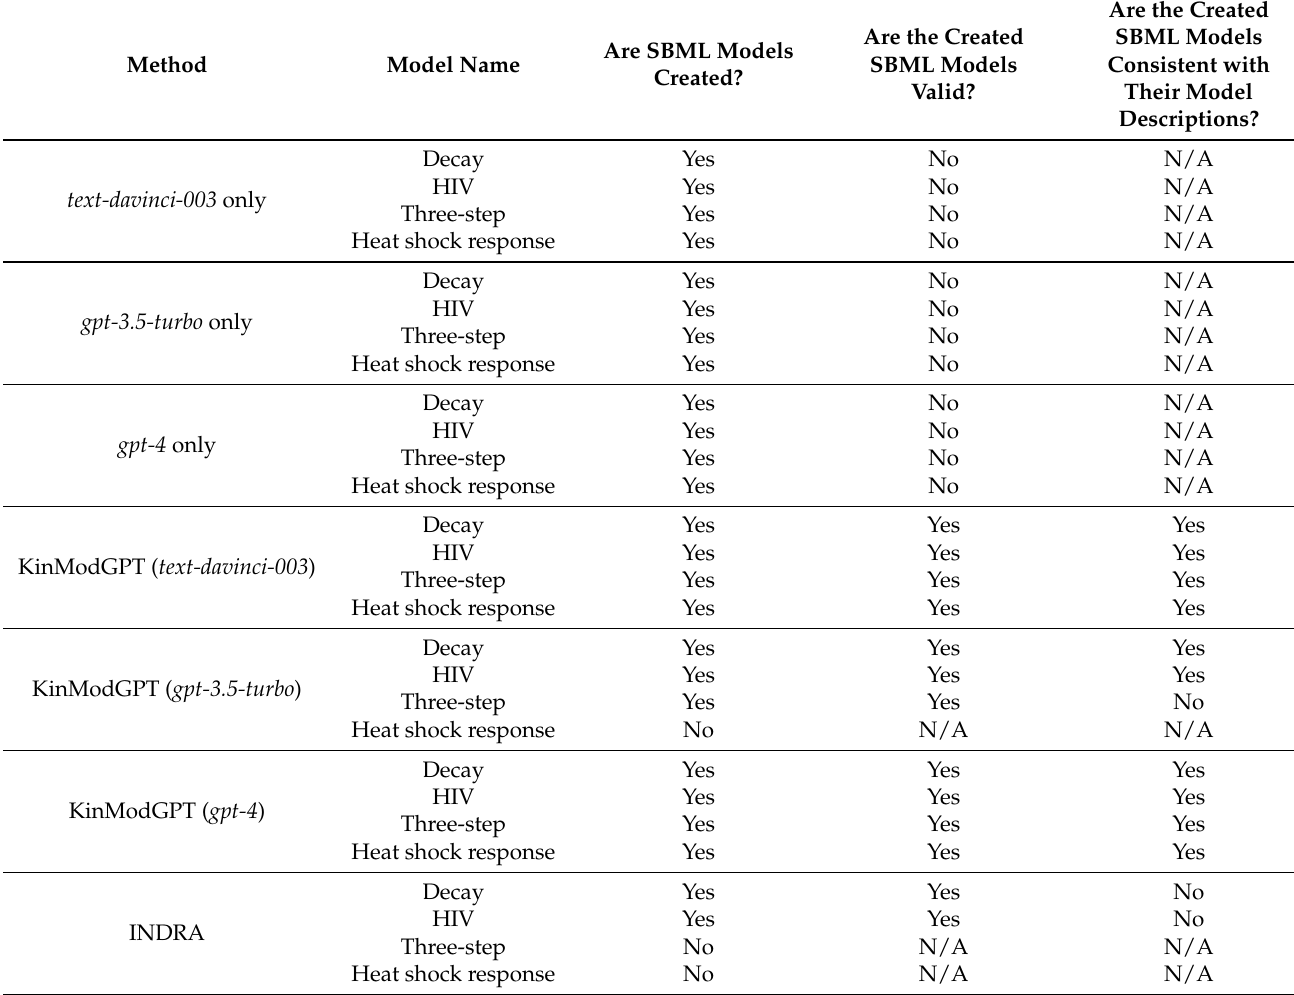
Table 1. Summary of the computational experiments. We converted four natural language model descriptions into SBML, using either of the GPT-only approaches, KinModGPT approaches, or INDRA (a competitor tool). In the KinModGPT approaches, either of the three GPT models ( text-davinci-003 , gpt-3.5-turbo , or gpt-4 ) was employed as a natural language interpreter. The validity of the generated SBML files was verified using the Online SBML Validator [27], and their consistency with the original model descriptions was manually